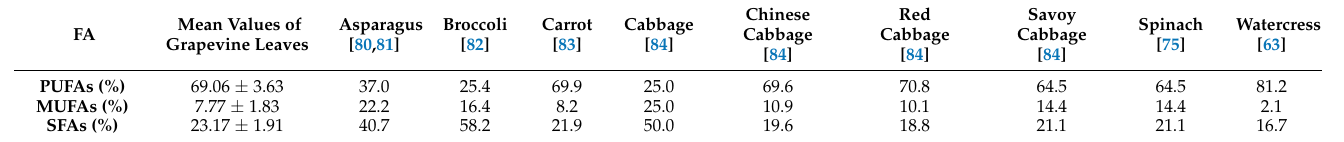
Table 6. Fatty acid percentage in different plants in comparison with grapevine leaves. FA Mean Values of Grapevine